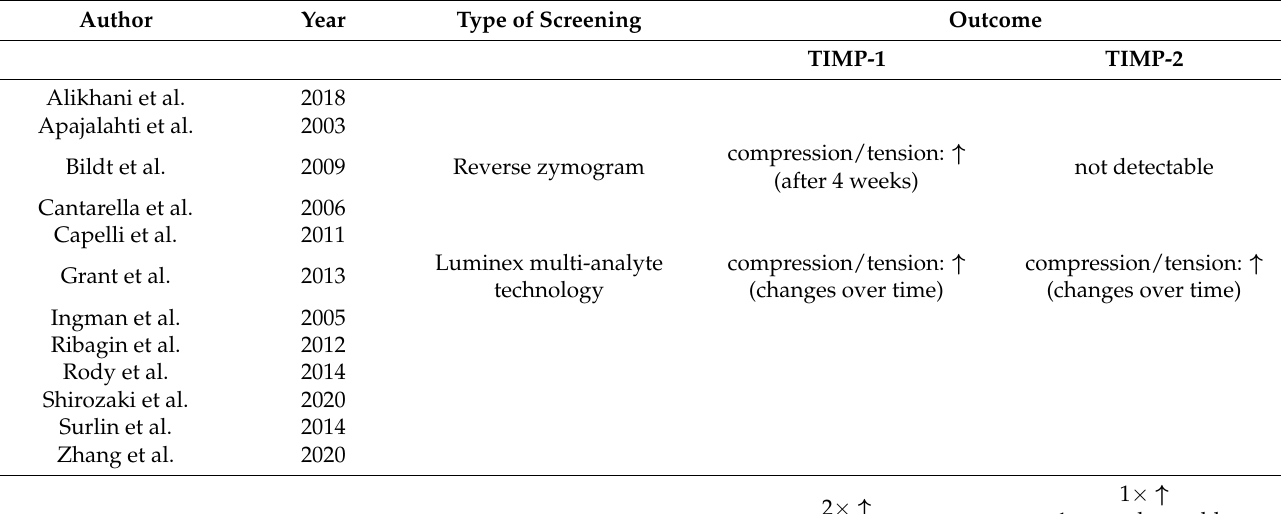
Table 8. TIMPs outcome of all included in vivo